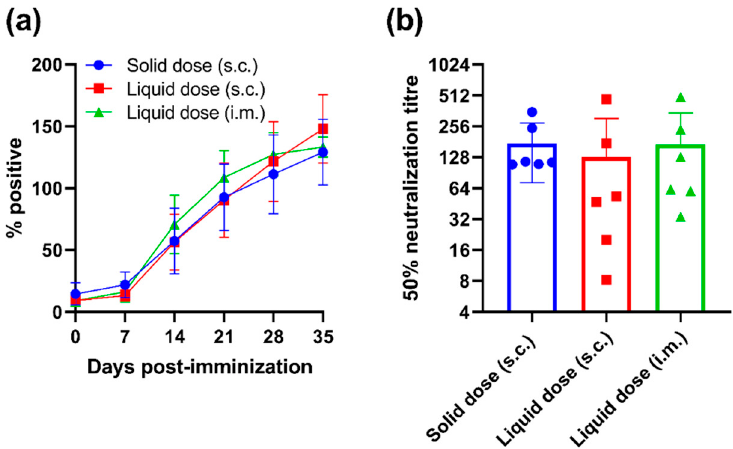
Figure 4. Assessment of antibody responses following immunisation of pigs with a unit solid dose injectable formulation of live attenuated PRRSV-1. Three groups of pigs (n = 6) were immunised by s.c. inoculation of a USDI formulation of 10 5 TCID 50 of PRRSV-1 Olot/91, or by s.c. or i.m. inoculation of a comparable dose of PRRSV-1 Olot/91 (s.c. liquid dose and i.m. liquid dose, respectively). ( a ) Longitudinal serum samples were assessed for PRRSV N protein-specific antibodies by ELISA and data presented as percent positive relative to the corrected OD 450 nm max. Results obtained above 30% positive are considered positive. ( b ) PRRSV-1 neutralising antibody titres were assessed in sera from 35 DPI using a virus neutralisation test. Data are presented as the reciprocal serum dilution that neutralised infection by 50% (50% neutralisation titre). Mean data ± SD are shown for each vaccine group.